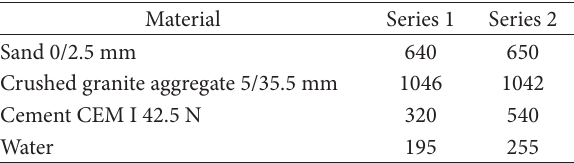
Table 1. Mix proportion of the experimental specimens, kg/m 3 Material Series 1 Series 2